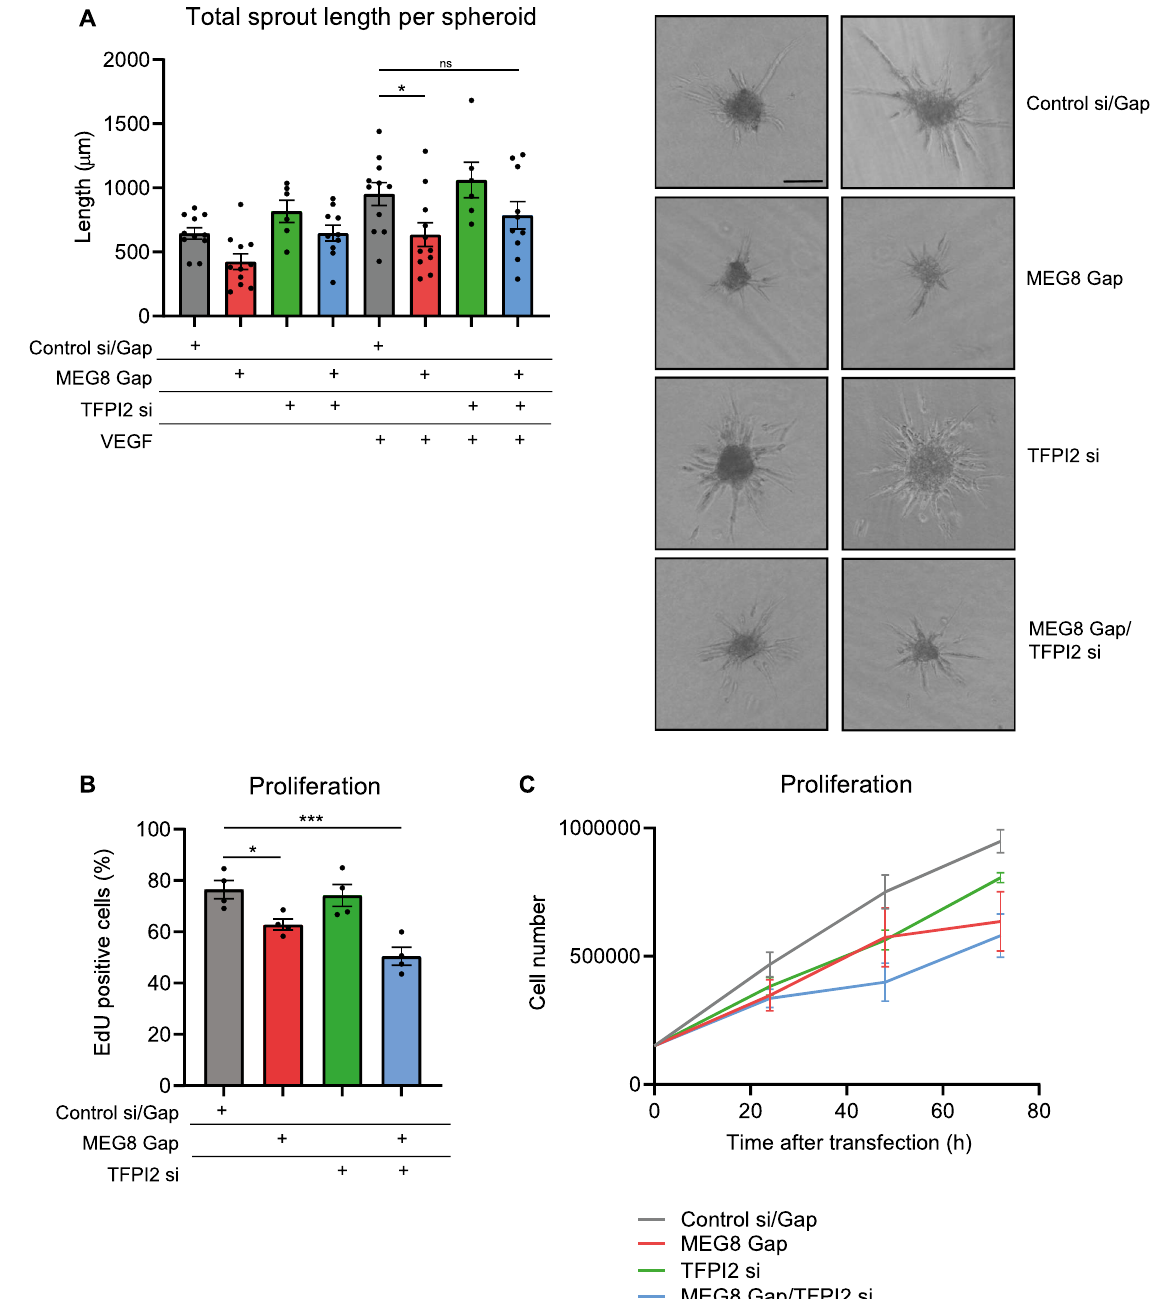
Figure 4. TFPI2 silencing rescues impaired sprouting after loss of MEG8. MEG8 and TFPI were knocked down by GapmeR and siRNA, respectively. ( A ) EC spheroids were embedded in collagen gels 24 h after transfection and stimulated with VEGF. Spheroid were fixed after 24 h VEGF stimulation. Cumulative sprout length was determined by measuring the distance from the base of the spheroid to the tip cell. Discontinuous sprouts were excluded. For each independent experiment 7–15 spheroids were scored. 10 independent experiments were performed. Scale bar indicates 100 µm. Multiple groups were analysed using one-way ANOVA. ( B ) Proliferation was measured by EdU incorporation between 24–48 h after transfection. The percentage of EdU-positive cells is shown. Multiple groups were analysed using one-way ANOVA ( C ) In addition, cell numbers were counted over time. HUVECs were seeded at equal densities and counted 24-, 48- and 72 h after transfection. Data are presented as mean ± SEM. Multiple groups were analysed using one-way ANOVA. Significance was indicated as: * p < 0.05, ** p < 0.01, *** p <